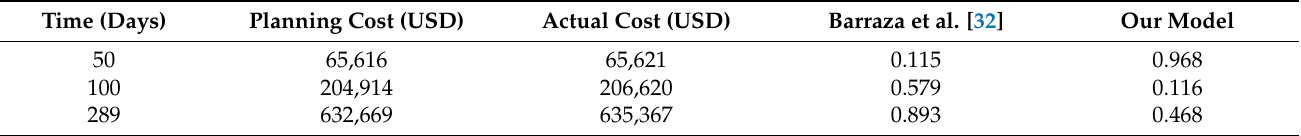
Table 2. Cost Overrun Probability Comparison between Barraza et al. [32] and Our Model.